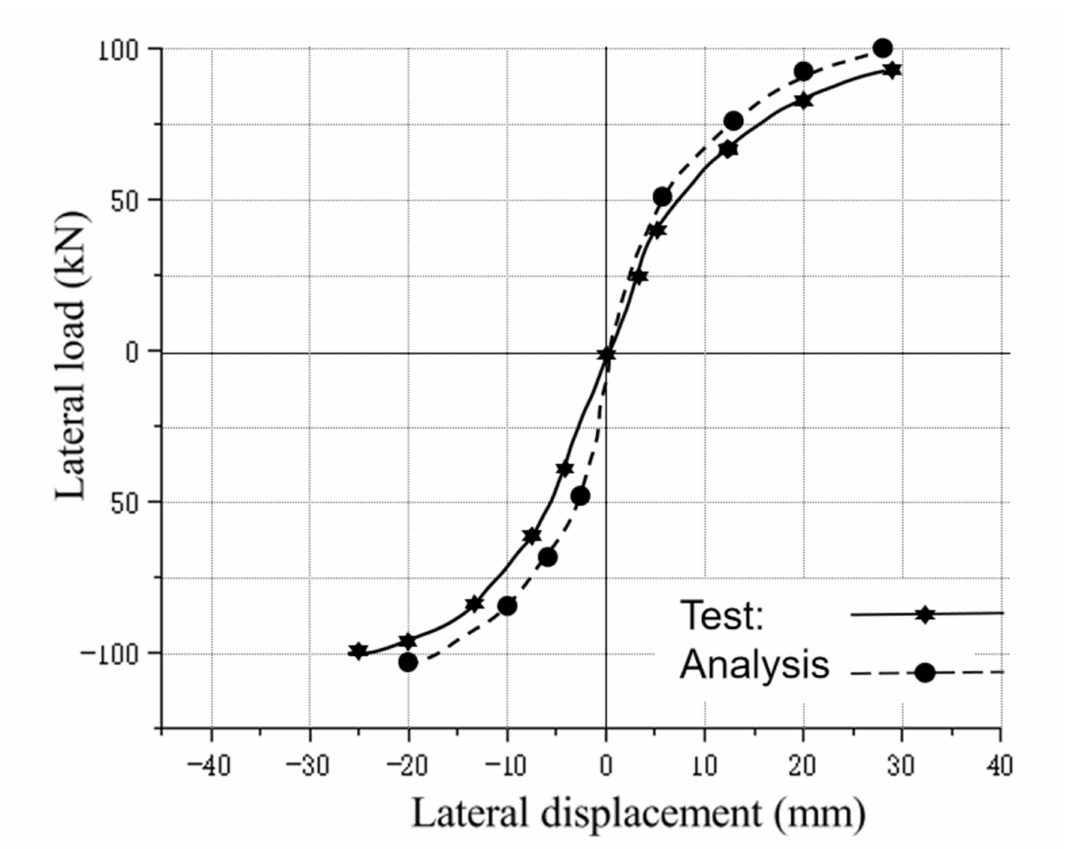
Figure 21. Comparison of test and analysis skeleton